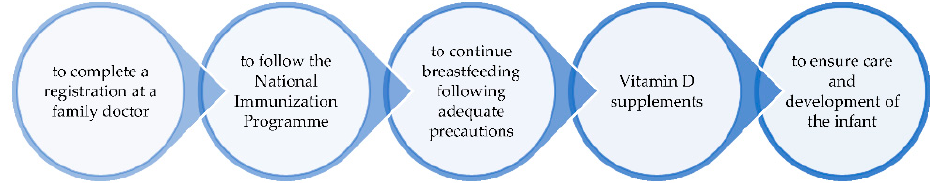
Figure 1. Recommendations at discharge.